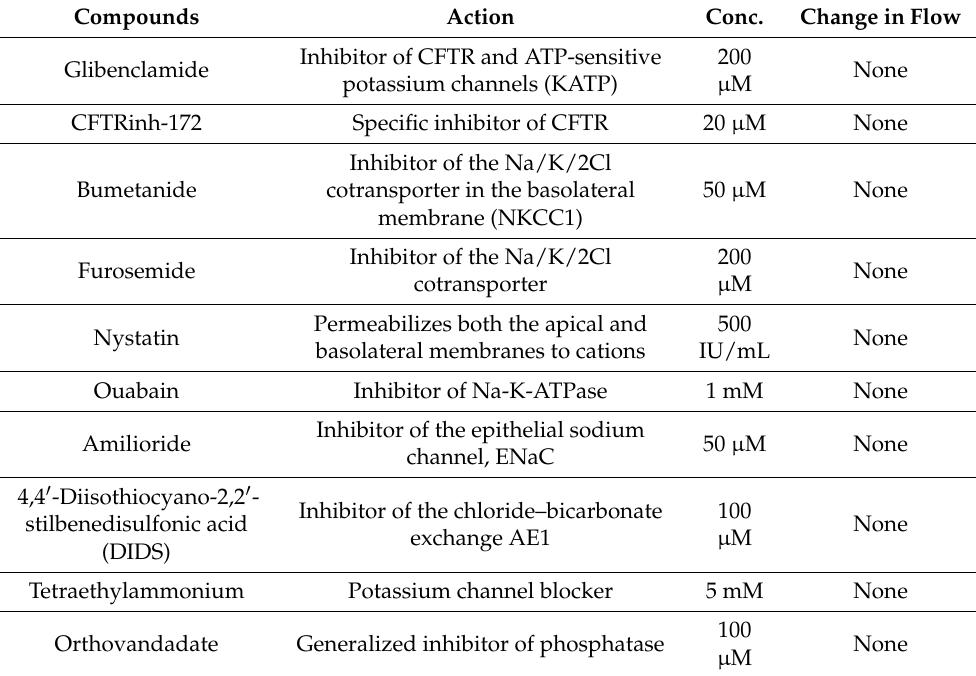
Table 2. Compounds used to alter transepithelia fluxes of chloride, sodium, and potassium by har- vested enterocytes cultured on inserts with 12 µ m pores. The known actions and final concentration in both chambers are provided. The change in fluid flow with vigorous aeration was based on comparisons of flows rates before and after addition of the inhibitors. Compounds Action Conc.